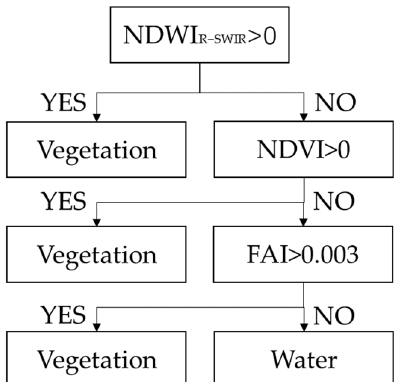
Figure 3. Decision trees used to extract vegetation signals; variables used include NDVI, FAI, and NDWI R ‐ SWIR .